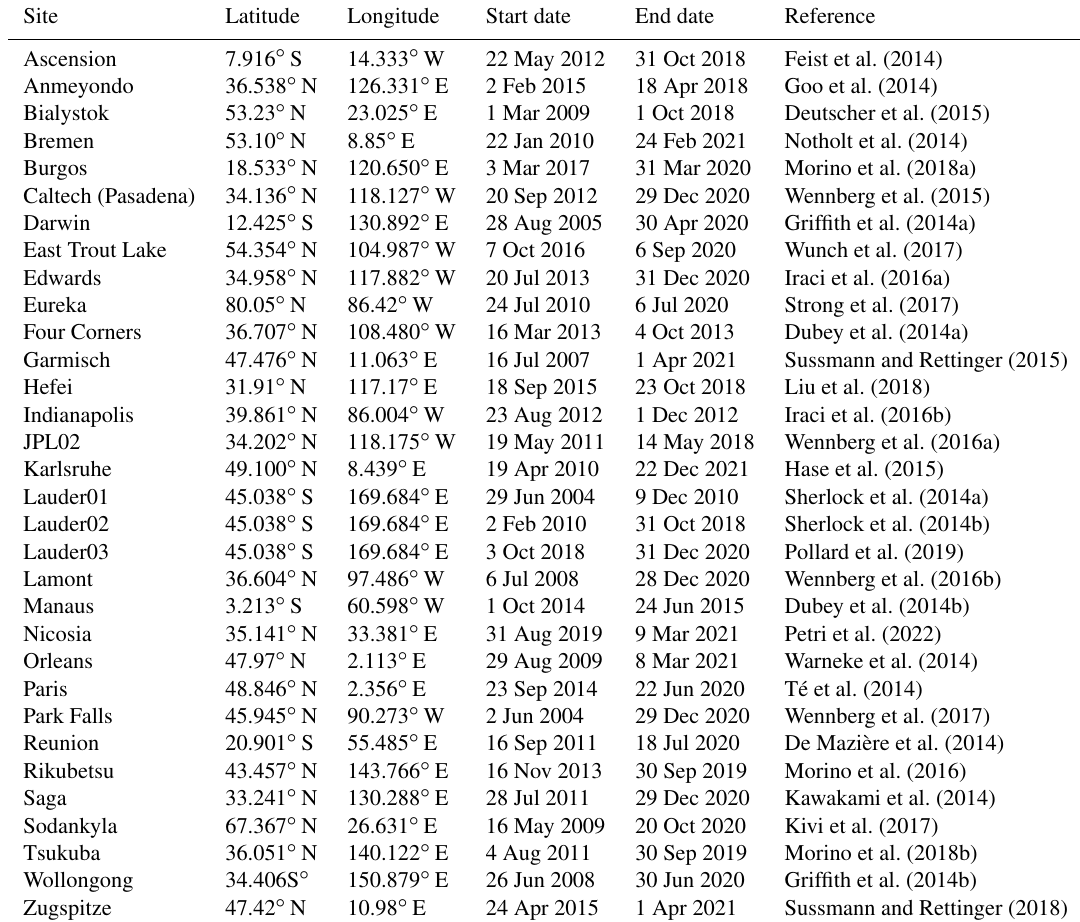
Table B3. Site information of the TCCON GGG2014 data used for bias